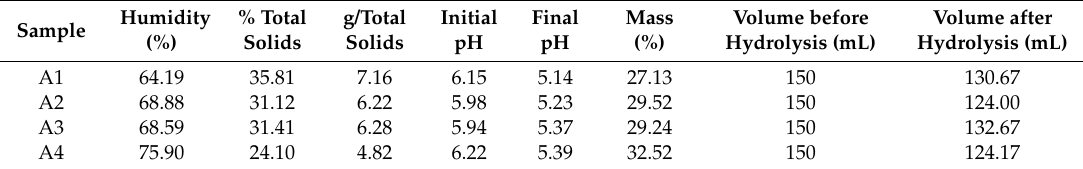
Table 2. Physical and chemical characterization of samples after